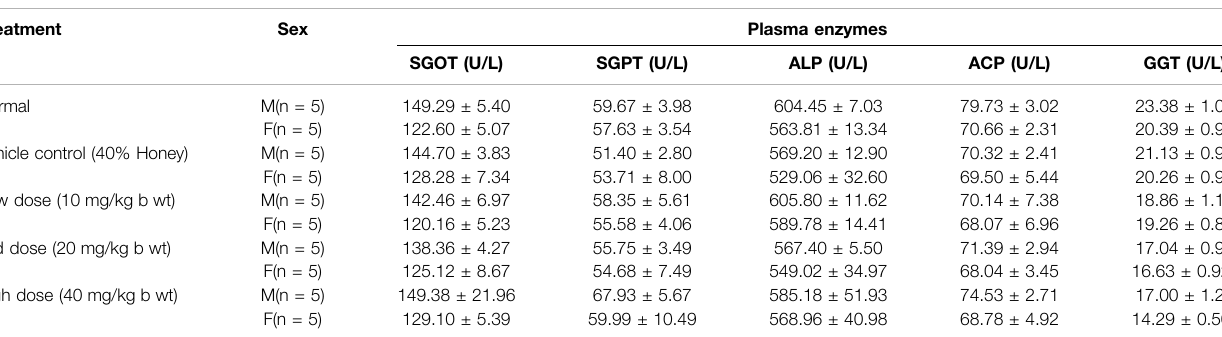
TABLE 7 | Effect of in — house Thamira parpam on 28th day: biochemical parameters (Enzymes). Treatment